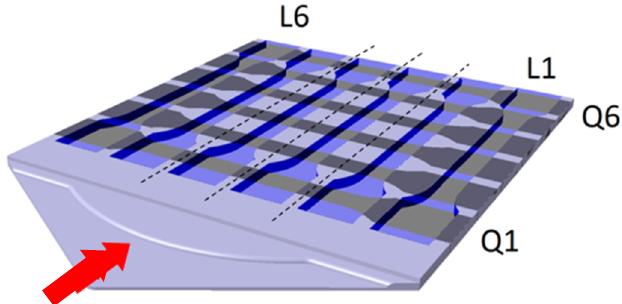
Figure 2. Schematic representation of the multipurpose test specimen, transverse and longitudinal to the fiber orientation in the plate.